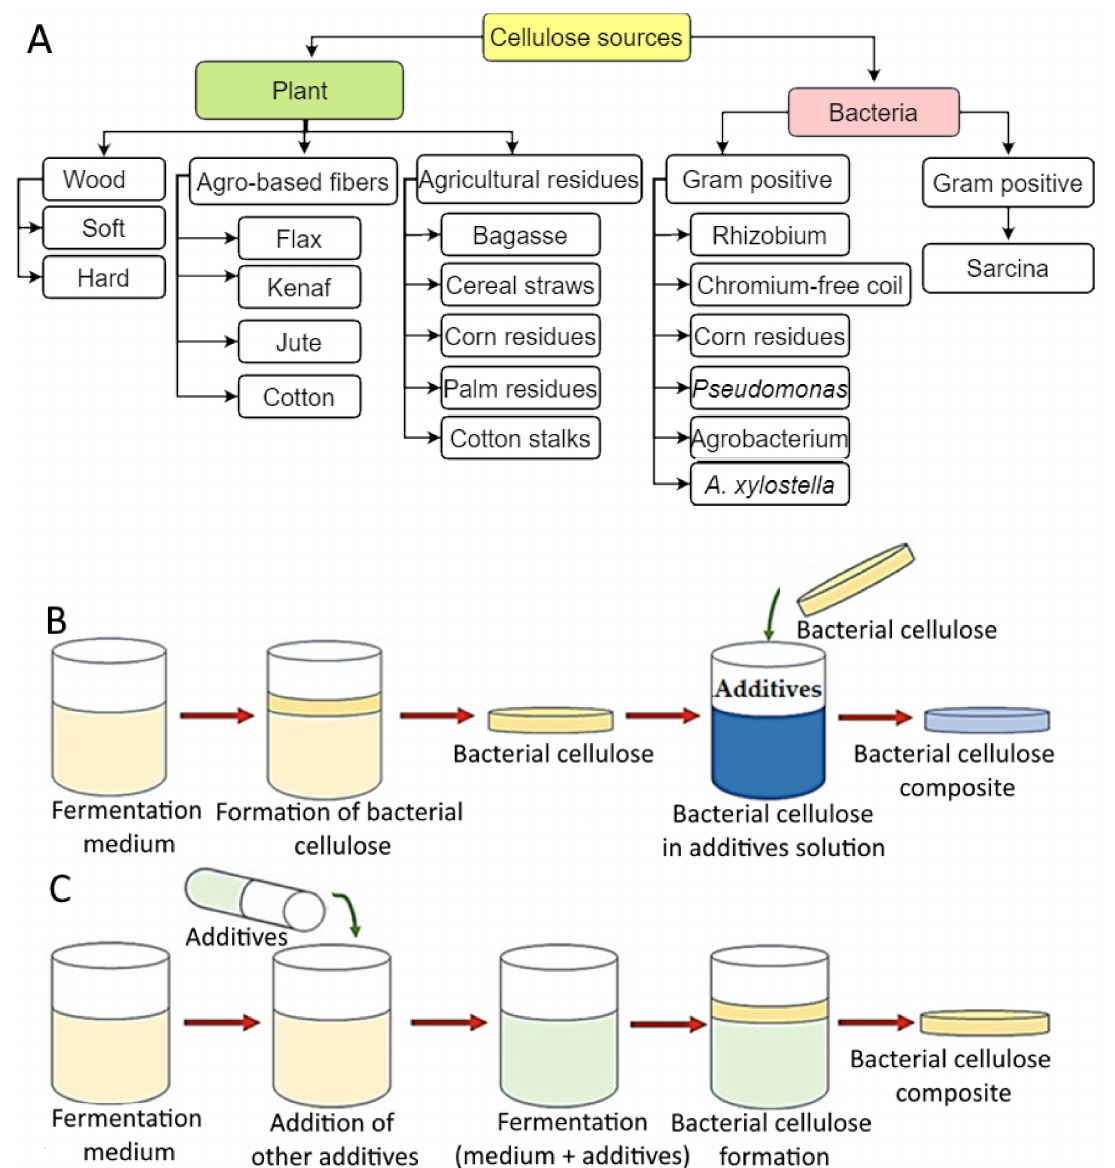
Figure 1. Cellulose sources for hydrogel production ( A ), and modification of bacterial cellulose using ( B ) ex situ and ( C ) in situ methods. Figure 1A is adapted from Chen et al. [41] and is